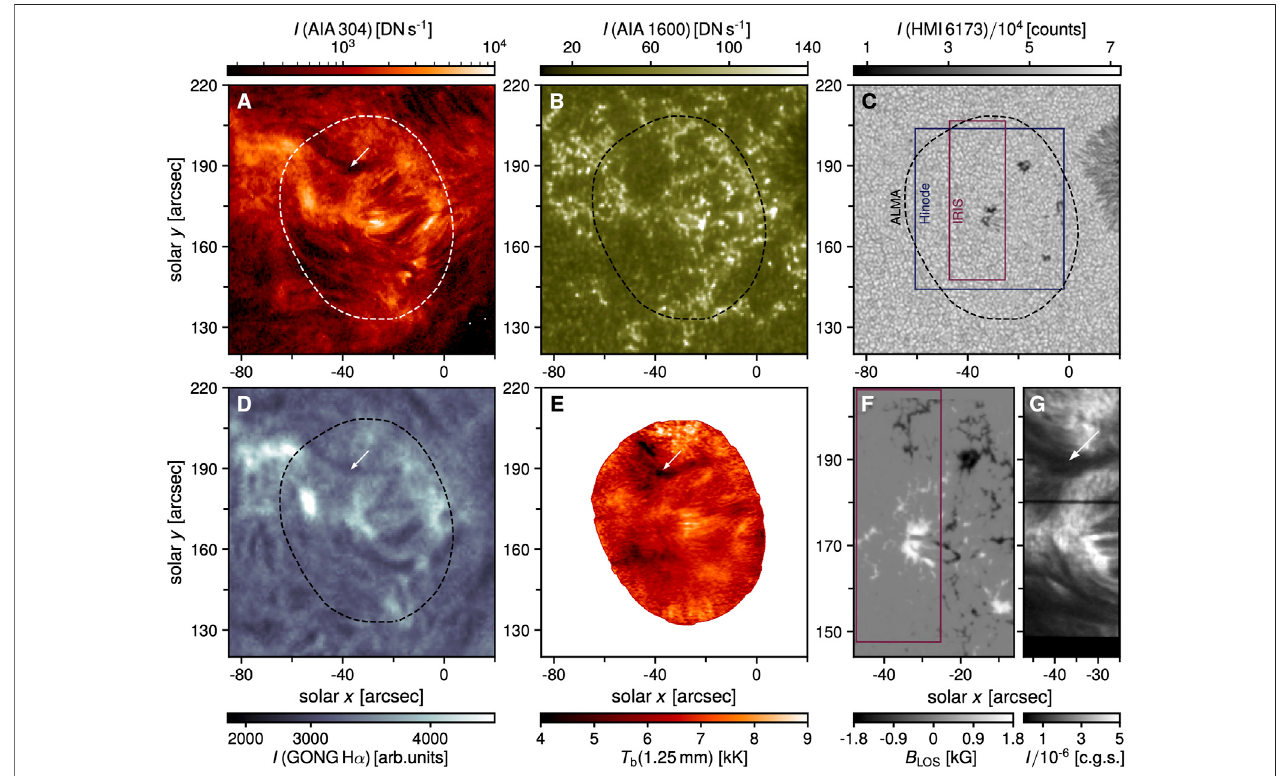
FIGURE1| OverviewofNOAAAR12738bydifferentinstrumentson13April2019,around14:15UT.Panel (A) SDO/AIA304 Åintensityinlogarithmicscale;panel (B) SDO/AIA1,600 Å intensity (capped); panel (C) deconvolved SDO/HMI 6173 Å continuum intensity; panel (D) gamma-adjusted and unsharpened GONG H α ; panel (E) ALMA Band 6 brightness temperature mosaic; panel (F) Hinode/SOT line-of-sight magnetogram; panel (G) IRIS intensity in the core of Mg II k (in units of erg s − 1 sr − 1 cm − 2 Hz − 1 ). The dashed lines show the ALMA fi eld of view, and the boxes in panel C show the area covered by the Hinode and IRIS raster scans. The arrows indicate the location of an AR fi